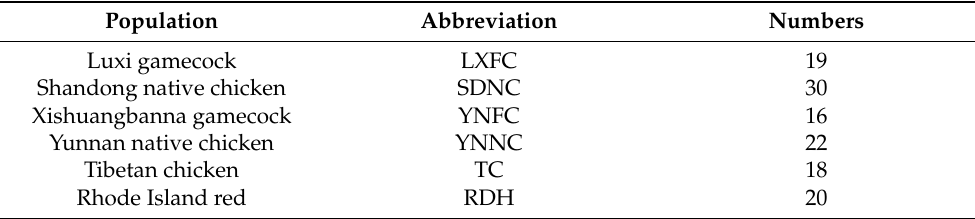
Table 1. Populations used for whole genome